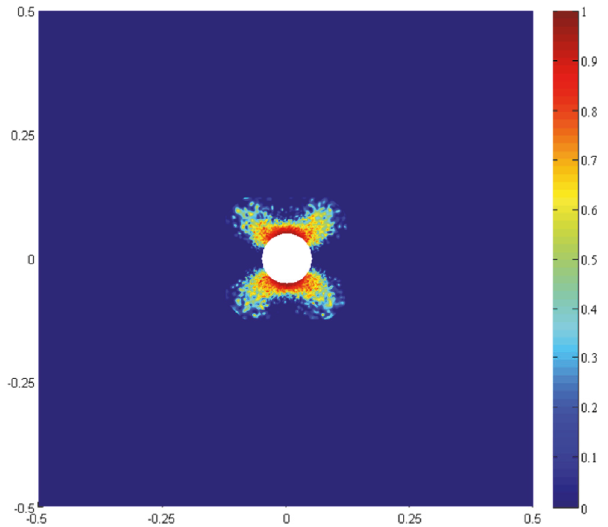
Figure 13: Damage distribution under lateral pressure coefficient 𝜆 = 3 . 𝜎